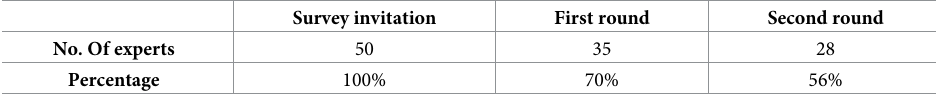
Table 2. Survey dropouts during the whole process.